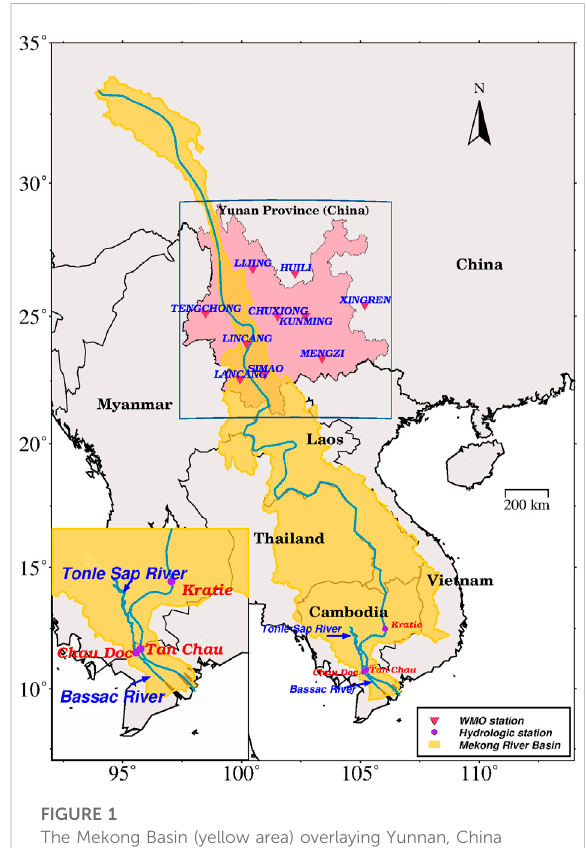
FIGURE 1 The Mekong Basin (yellow area) overlaying Yunnan, China (pink area), with World Meteorological Organization (WMO) meteorological stations (red triangle) along with hydrologic stations within the river delta (purple